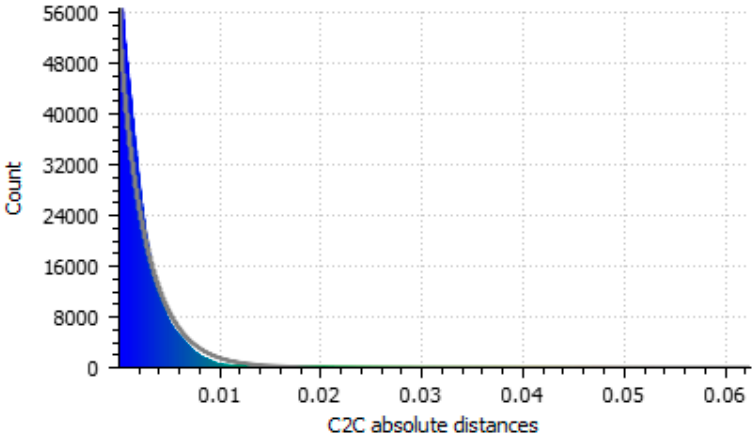
Figure 15. Measured differences between model generated by the camera and Samsung phone, ( top )—visualization of differences projected on model, ( bottom )—distribution of measured differences.